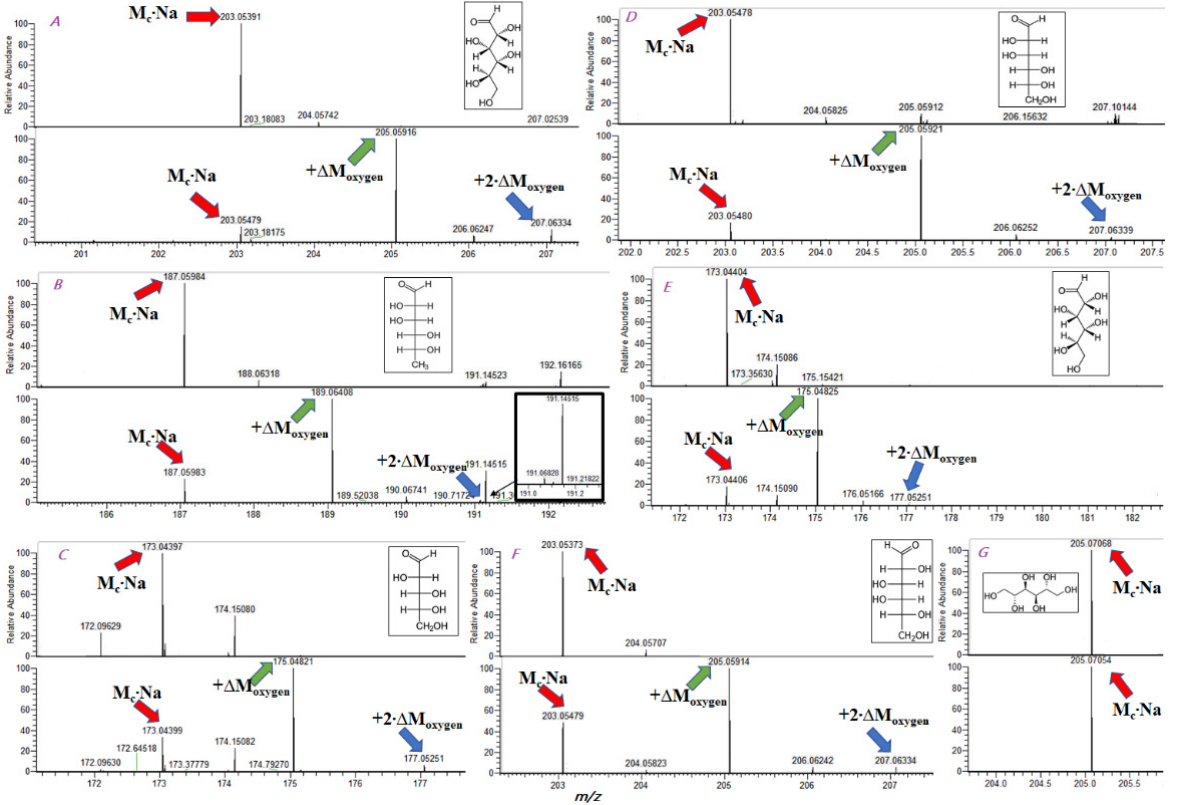
Figure 1. ( A ) Experimental spectrum of D-glucose (positive mode) before (upper) and after (lower) 16 O/ 18 Oexchange reaction. ( B ) Experimental spectrum of D-rhamnose (positive mode) before (upper) and after (lower) 16 O/ 18 Oexchange reaction. ( C ) Experimental spectrum of D-arabinose (positive mode) before (upper) and after (lower) 16 O/ 18 Oexchange reaction. ( D ) Experimental spectrum of D-mannose (positive mode) before (upper) and after (lower) 16 O/ 18 Oexchange reaction. ( E ) Exper- imental spectrum of D-xylose (positive mode) before (upper) and after (lower) 16 O/ 18 Oexchange reaction. ( F ) Experimental spectrum of D-galactose (positive mode) before (upper) and after (lower) 16 O/ 18 Oexchange reaction. ( G ) Experimental spectrum of mannitol (positive mode) before (upper) and after (lower) 16 O/ 18 Oexchange reaction. Top subfigure indicates no exchange. Bottom subfigure indicates after